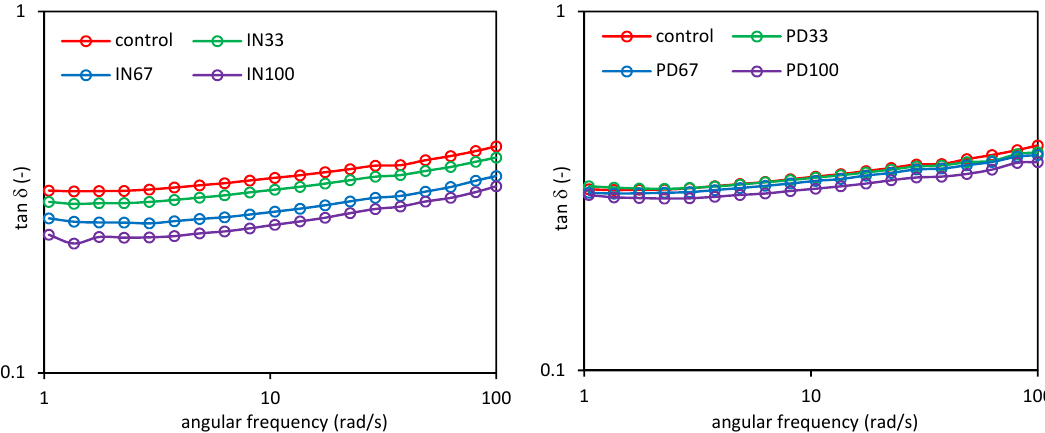
Figure 5. Tangent of the phase shift angle of potato starch based desserts: without steviol glycosides (control), with inulin (IN33, IN67, IN100), with polydextrose (PD33, PD67, PD100)